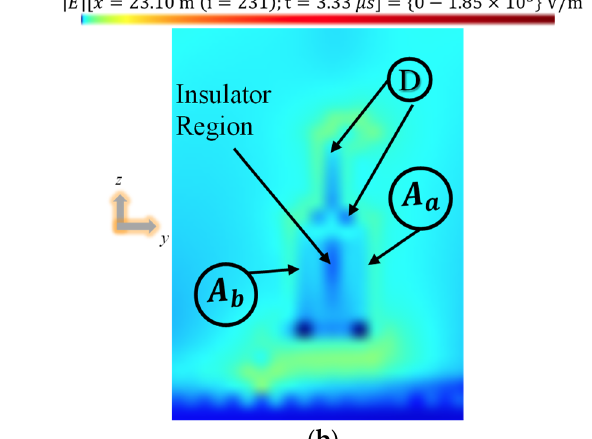
(cid:12) (cid:12) (cid:12) (cid:12) (cid:12) H (cid:12) and (cid:12) E (cid:12) calculated using the FDTD method for PC6: (cid:12) (cid:12) (cid:12) E (cid:12) ( x = 23.10 m, t = 3.33 µ s )